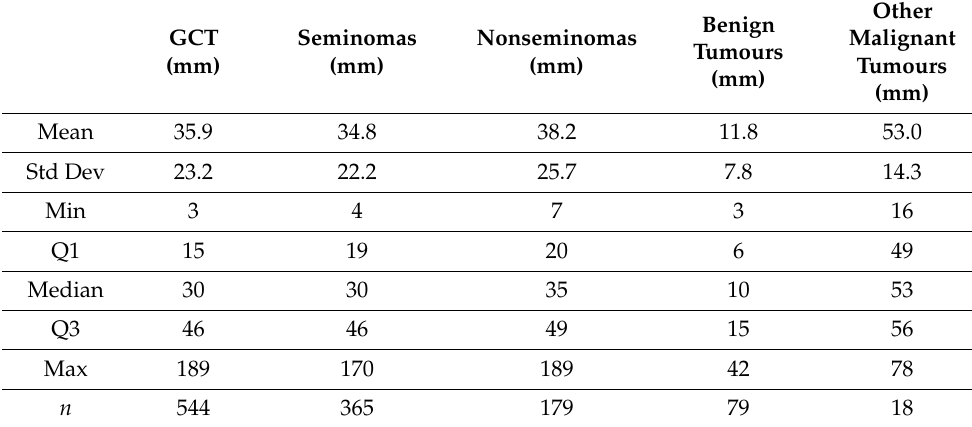
Table 2. Distribution of tumour sizes stratified by histologic